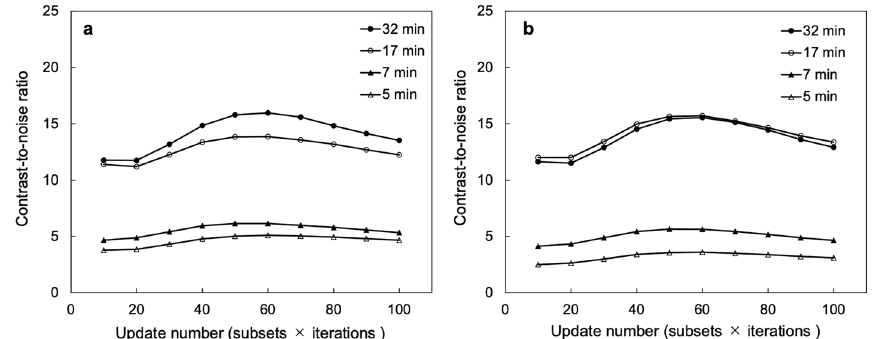
Fig. 5 Relationship between update number and contrast-to-noise ratio (CNR). CNR of various acquisition times using a SwiftScan SPECT and b step and shoot mode (SSM). The update number is the product of the subset and the iterations